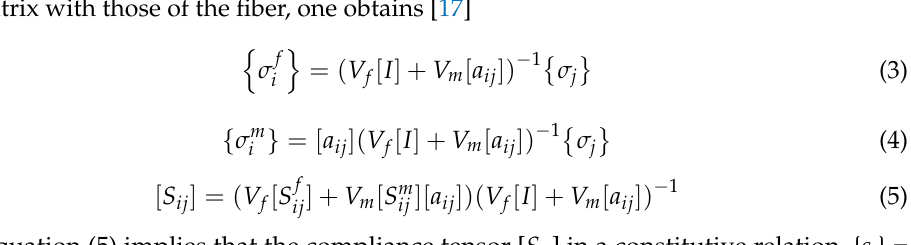
(cid:110) (cid:111) (cid:9) (cid:8) ] σ m σ f = [ a , to correlate the homogenized stresses of ij i j